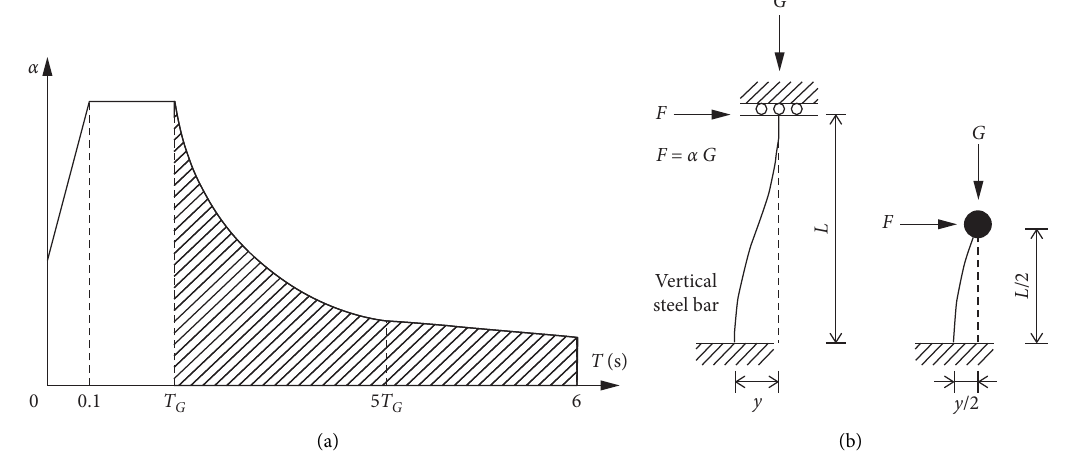
Figure 2: The isolation principle of the rebar isolation pier: (a) seismic influence coefficient curve and (b) simplified calculation model of vertical steel bar.